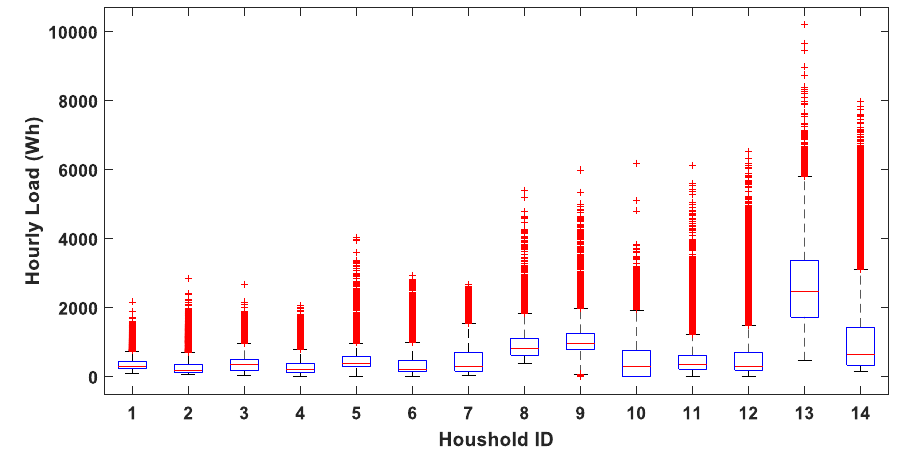
Fig. 1. Boxplot statistics for the